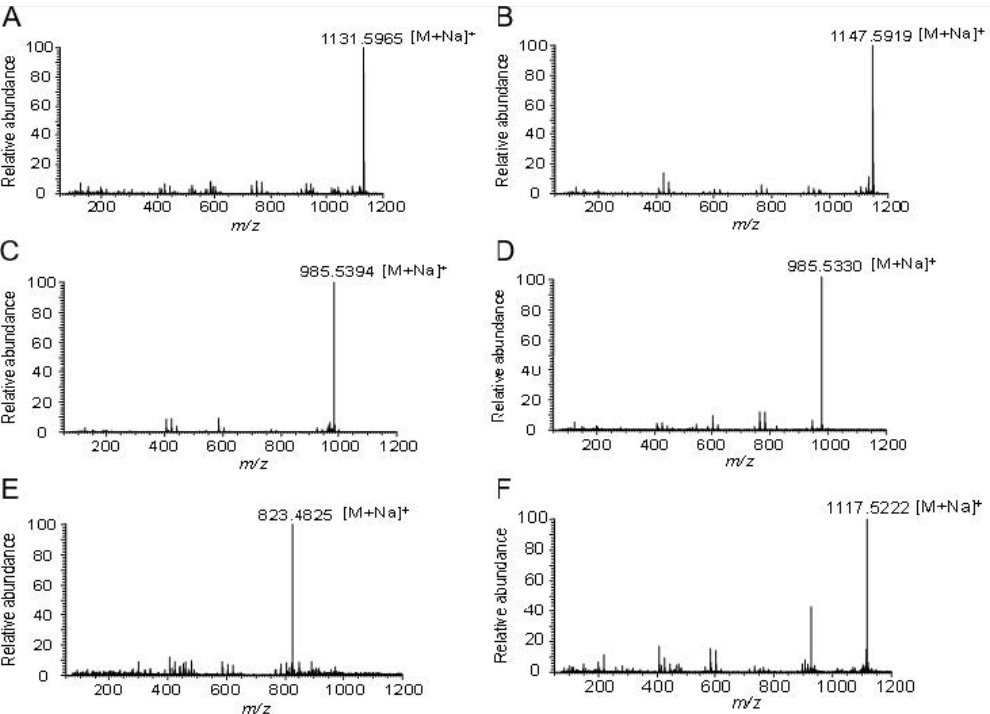
Figure 3. HR-ESI-MS analysis of the glycosylated products catalyzed by UGT109A1. ( A ) Product 1 synthesized from ginsenoside Re; ( B ) Product 2 synthesized from ginsenoside Rf; ( C ) Product 3 synthesized from ginsenoside Rf; ( D ) Product 4 synthesized from ginsenoside Rh1; ( E ) Product 5 synthesized from ginsenoside Rh1; ( F ) Product 6 synthesized from ginsenoside R1.